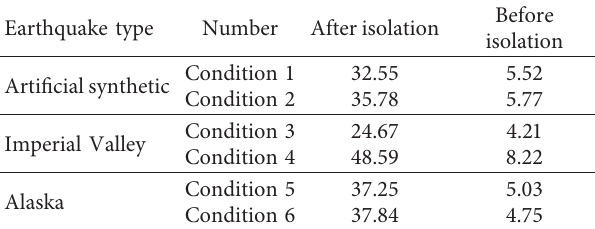
Table 8: Deck displacements before and after isolation (mm). Earthquake type